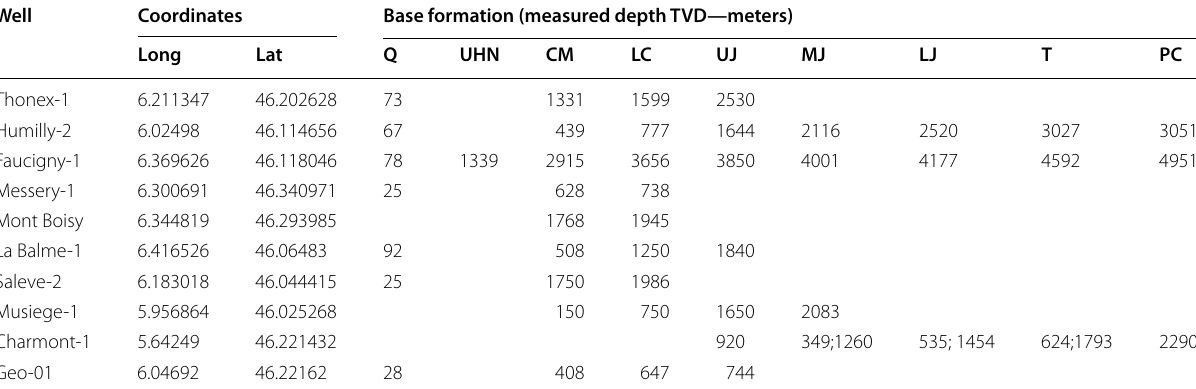
Q: Quaternary, UHN: Ultra-Helvetic Nappe, CM: Cenozoic Molasse, LC: Lower Cretaceous, UJ: Upper Jurassic, MJ: Middle Jurassic, LJ: Lower Jurassic, T: Triassic, PC: Permo-Carboniferous